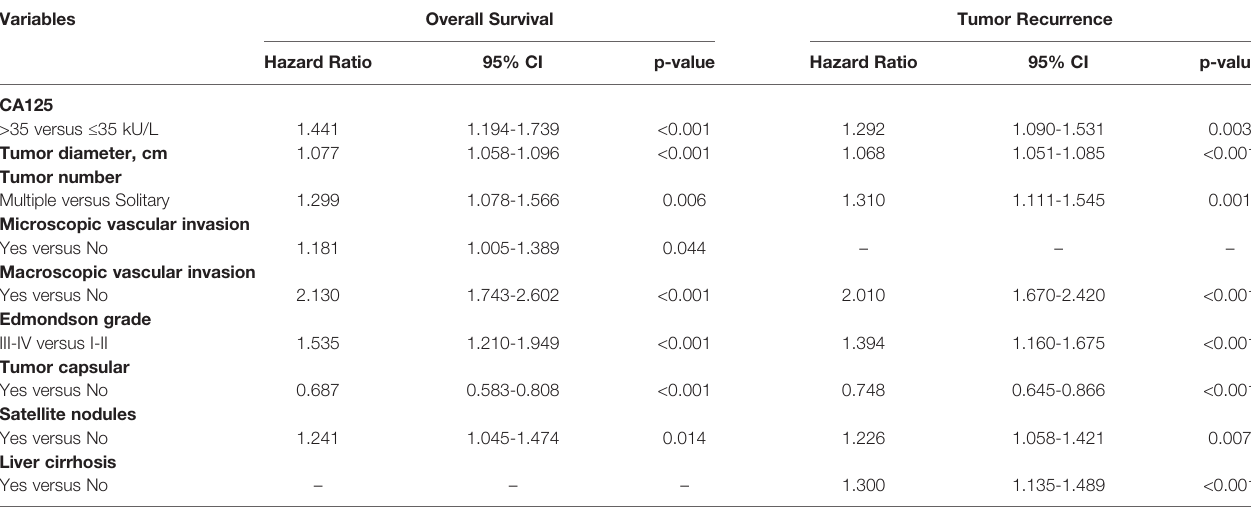
TABLE 2 | Multivariate analysis of factors associated with overall survival and tumor recurrence after curative hepatectomy.